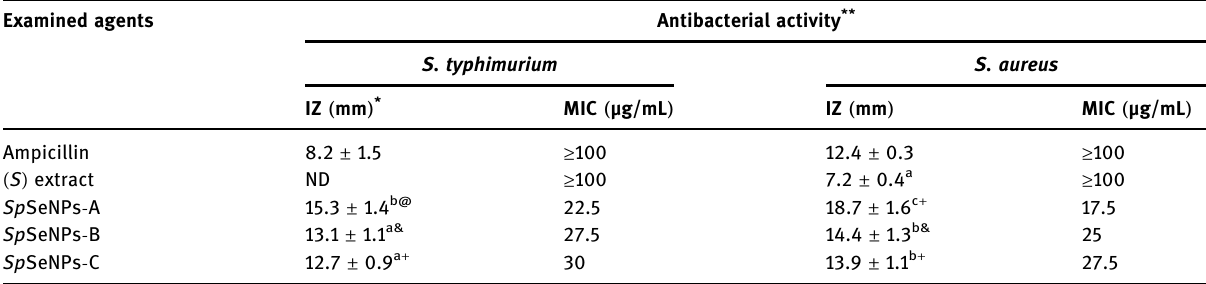
Table 2: Antimicrobial potentialities of Sp SeNPs phycosynthesized by S. platensis extract Examined